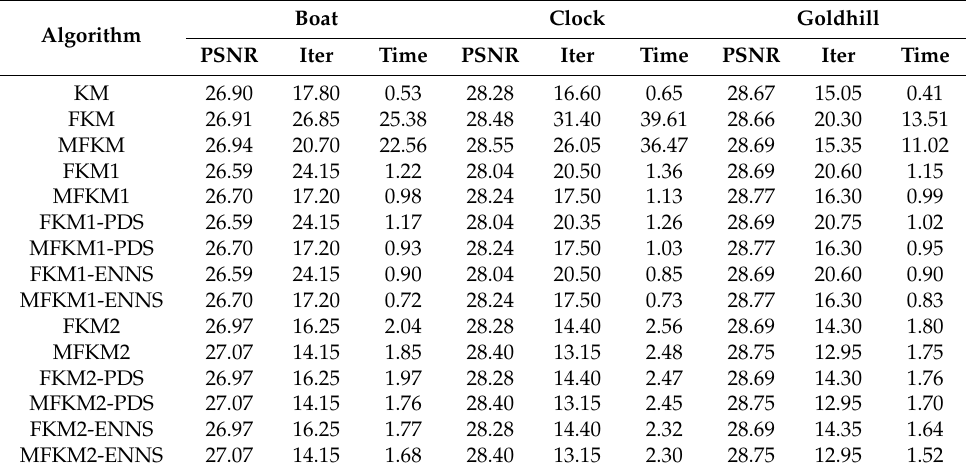
Table 7. PSNR (in dB), number of iterations and codebook design time (in seconds) for images Boat, Clock and Goldhill, using N =